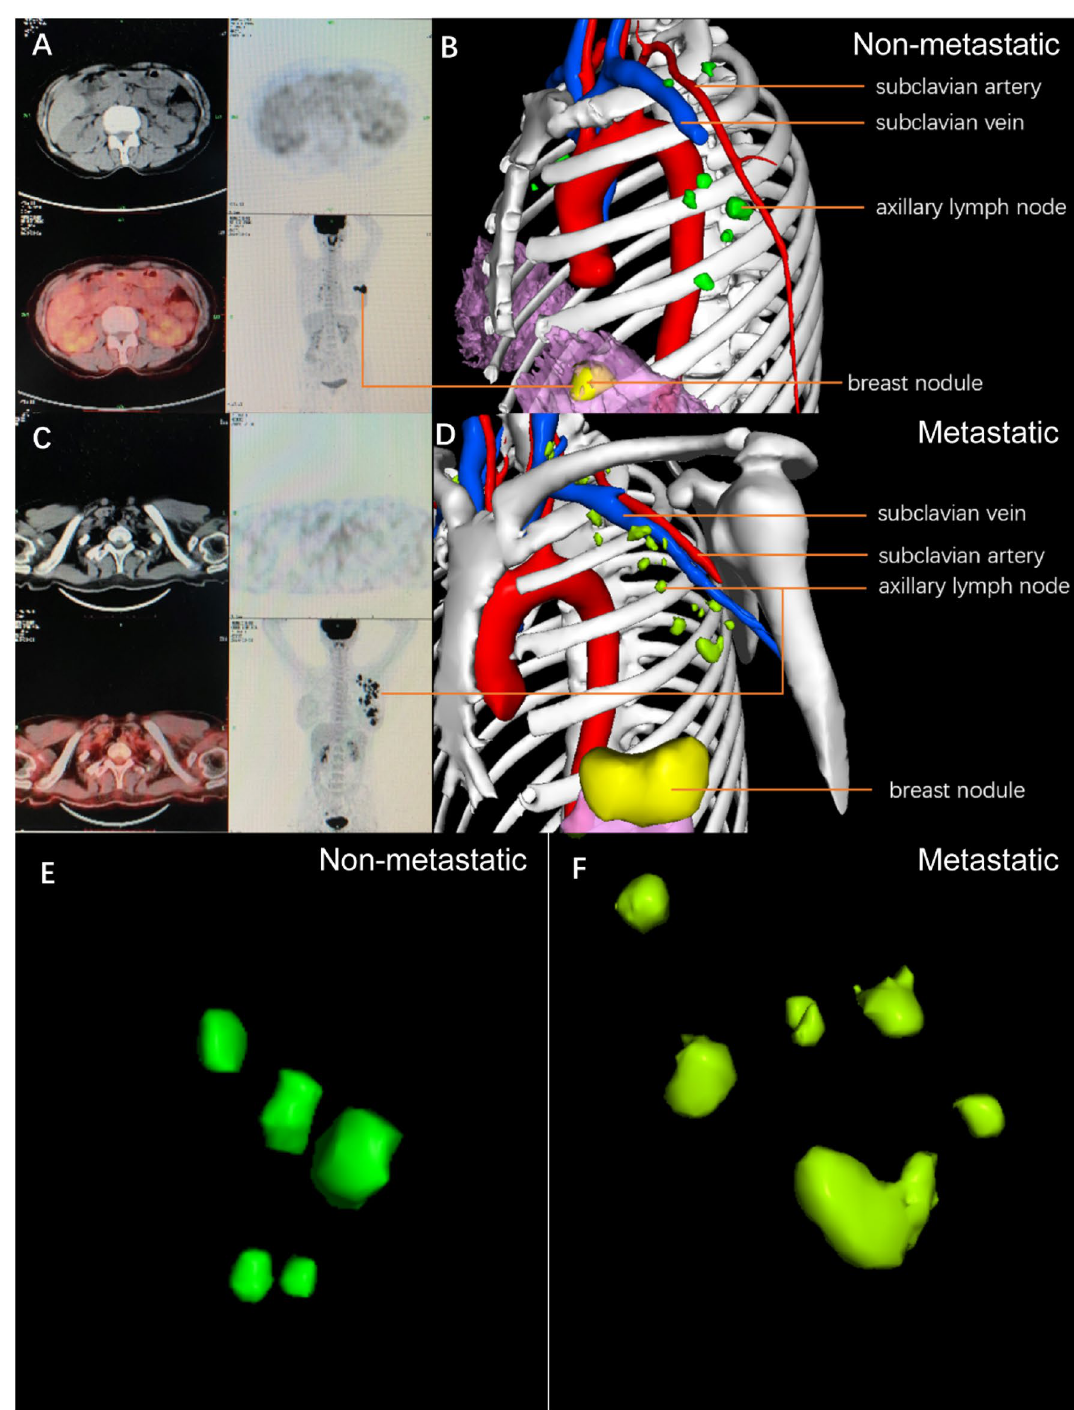
Figure 2. Comparison of PET-CT images with the 3D reconstruction system for the display of suspected metastatic lymph nodes. ( A ) and ( C ): Positron emission tomography/computed tomography images of non- metastatic ( A ) and metastatic patients ( C ); ( B ) and ( D ): 3D reconstruction images of non-metastatic ( B ) and metastatic patients ( D ); ( E ) and ( F ): 3D reconstruction local magnified images of non-metastatic ( E ) and metastatic patients ( F